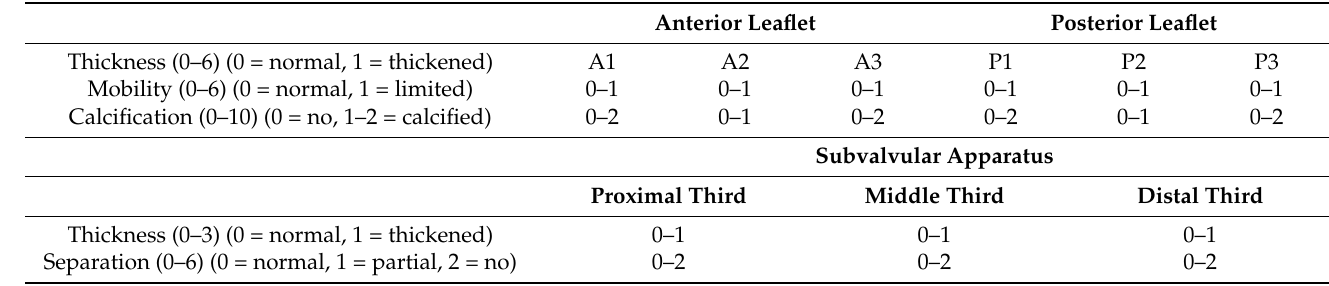
Table 3. Anwar score. The total score is the sum of the items (ranging from 4 to 16). Mild mitral valve involvement is defined as < 8 points, moderate involvement as 8 to 13 and severe MV involvement as > 14 points. Adapted from Anwar et al.